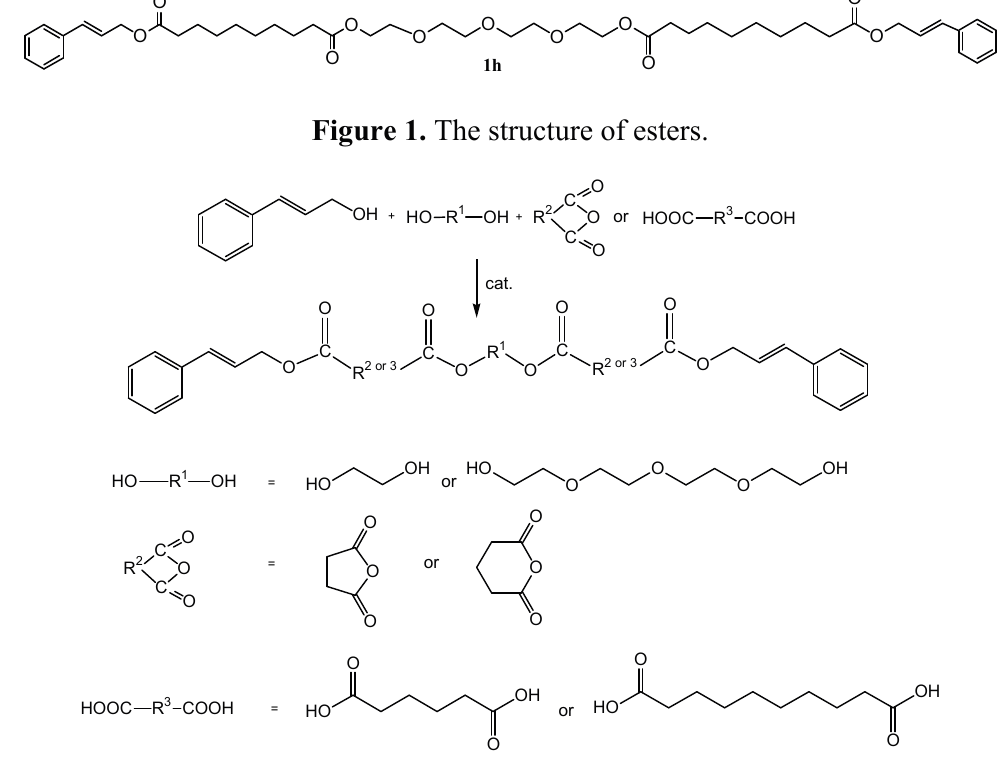
Figure 1. The structure of esters.